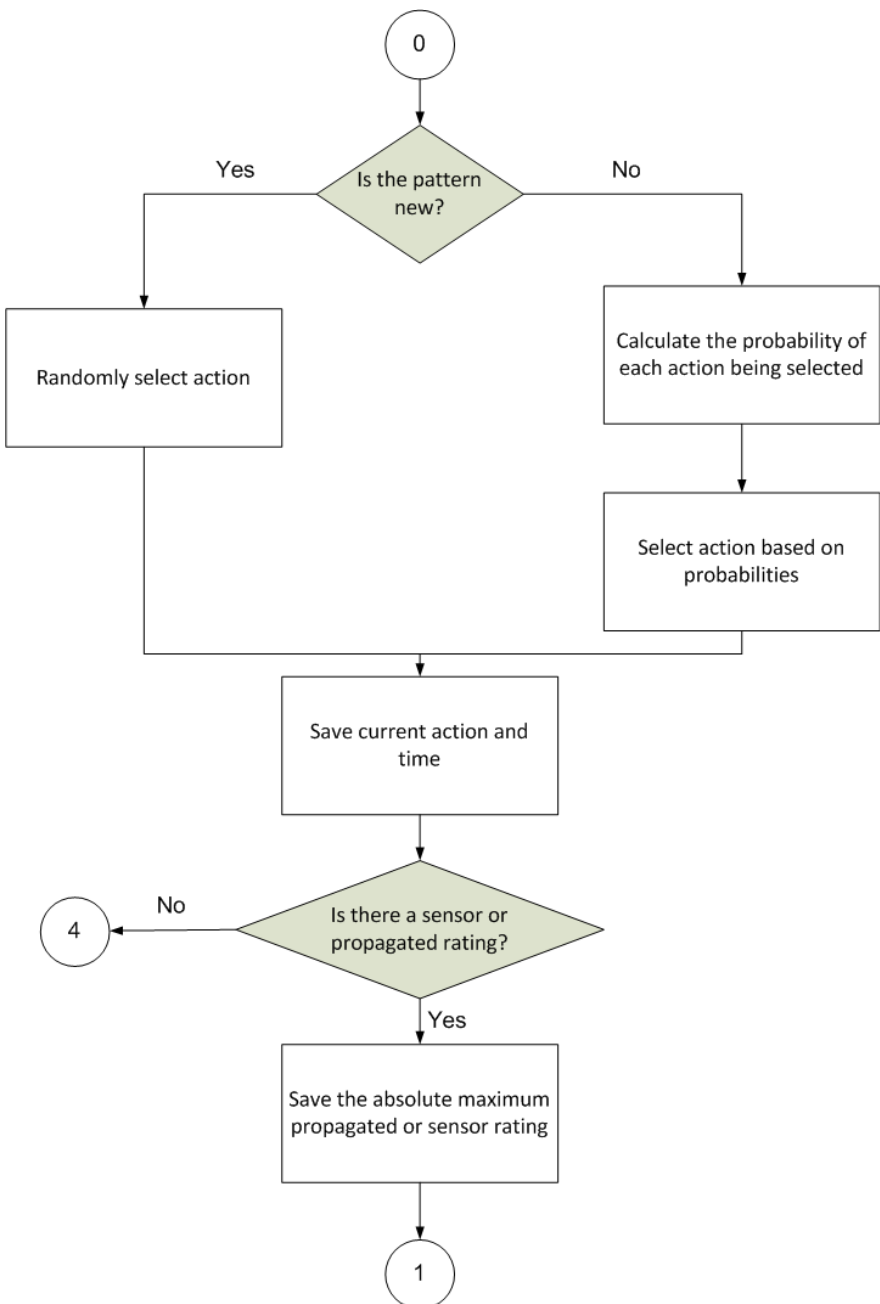
Figure 3. Action selection diagram (0 is the initial state of this diagram; state 1 continues in Figure 4; state 4 continues in Figure 6).